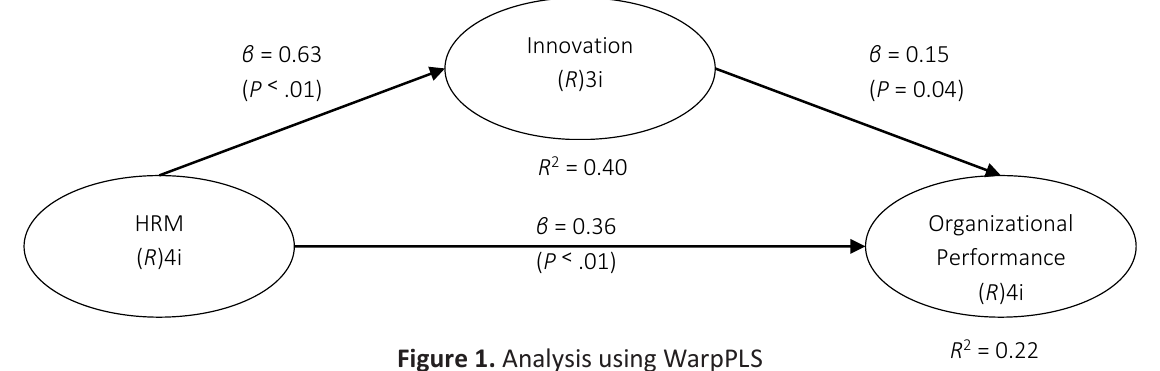
Figure 1. Analysis using